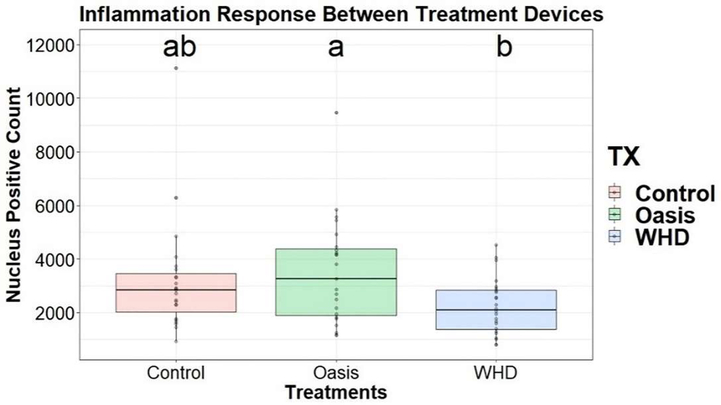
CD163 positive stain count compared across treatments. Compact letter display illustrates significant differences between treatments when p-value <0.05. WHD treatment had significantly less macrophage presence during healing compared to Oasis.